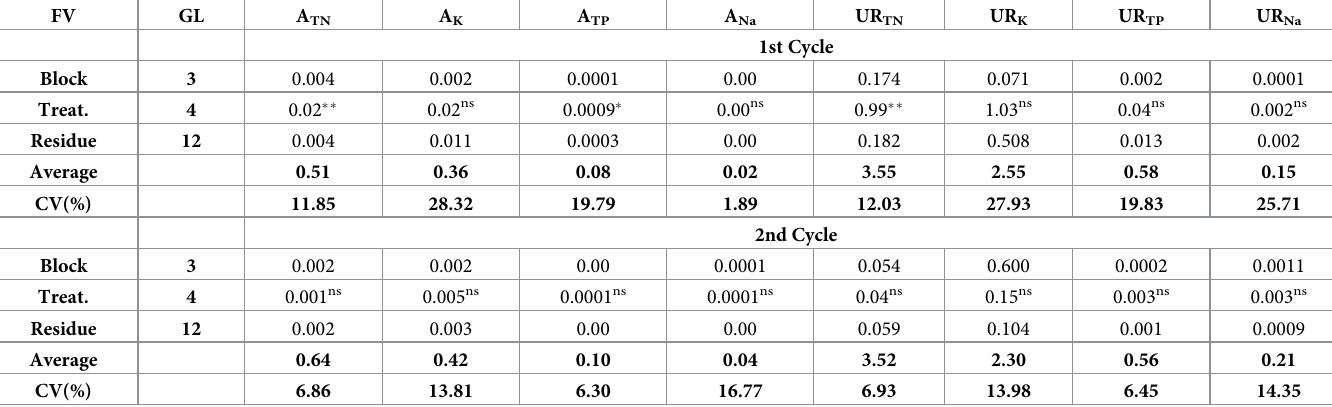
Table 8. Summary of the analysis of variance for the parameters of nutrients/Na accumulation and nutrients/Na uptake rate by Tifton 85 bermudagrass in the first and second cropping cycles.